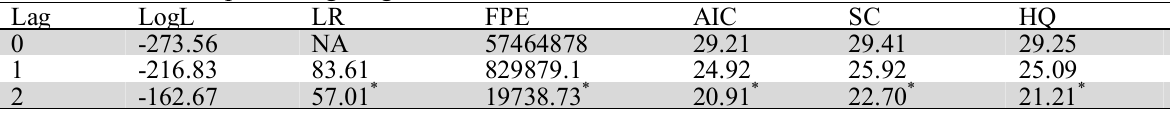
Determination of optimal lag